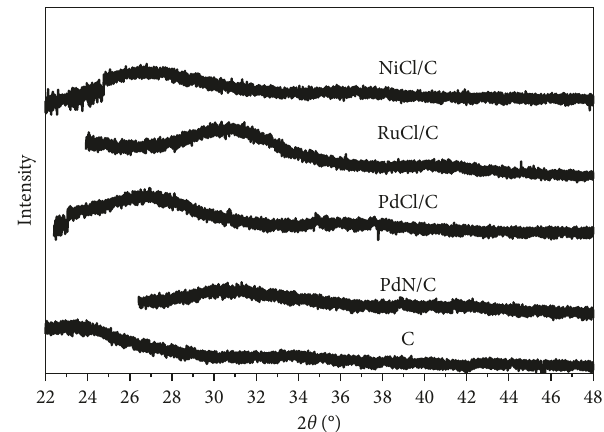
Figure 4: DRX diffractograms of PdN/C, PdCl/C, RuCl/C, and NiCl/C catalysts treated in H 2 at 393K and the CNR